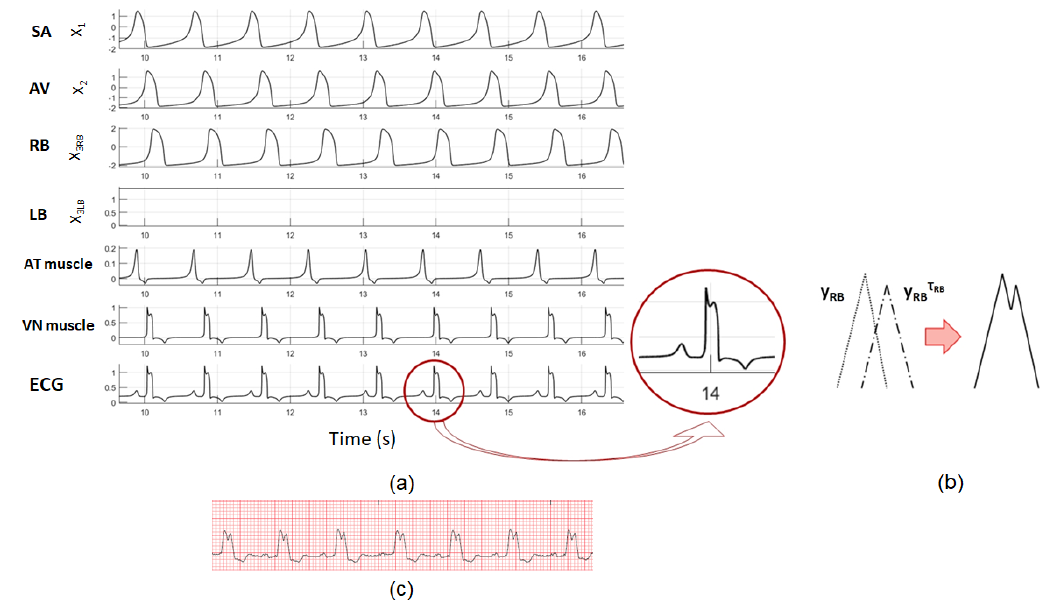
Figure 6. Simulation results for Left Bundle Branch Block (LBBB). ( a ) action potentials, muscles response and ECG signal in the LBBB case; ( b ) extra deflection of the QRS complex due to the rapid depolarization of the right ventricle followed by the slower depolarization of the left ventricle; ( c ) real ECG signal affected by LBBB